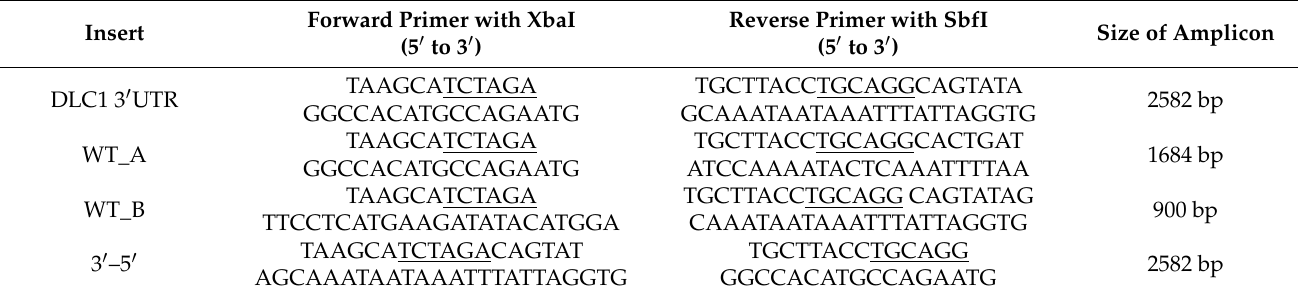
Table 1. The primer sequences for DLC1 3 (cid:48) UTR, WT-A, WT-B, and 3 (cid:48) -5 (cid:48) inserts. The underlined sequence is the restriction enzyme sequence.